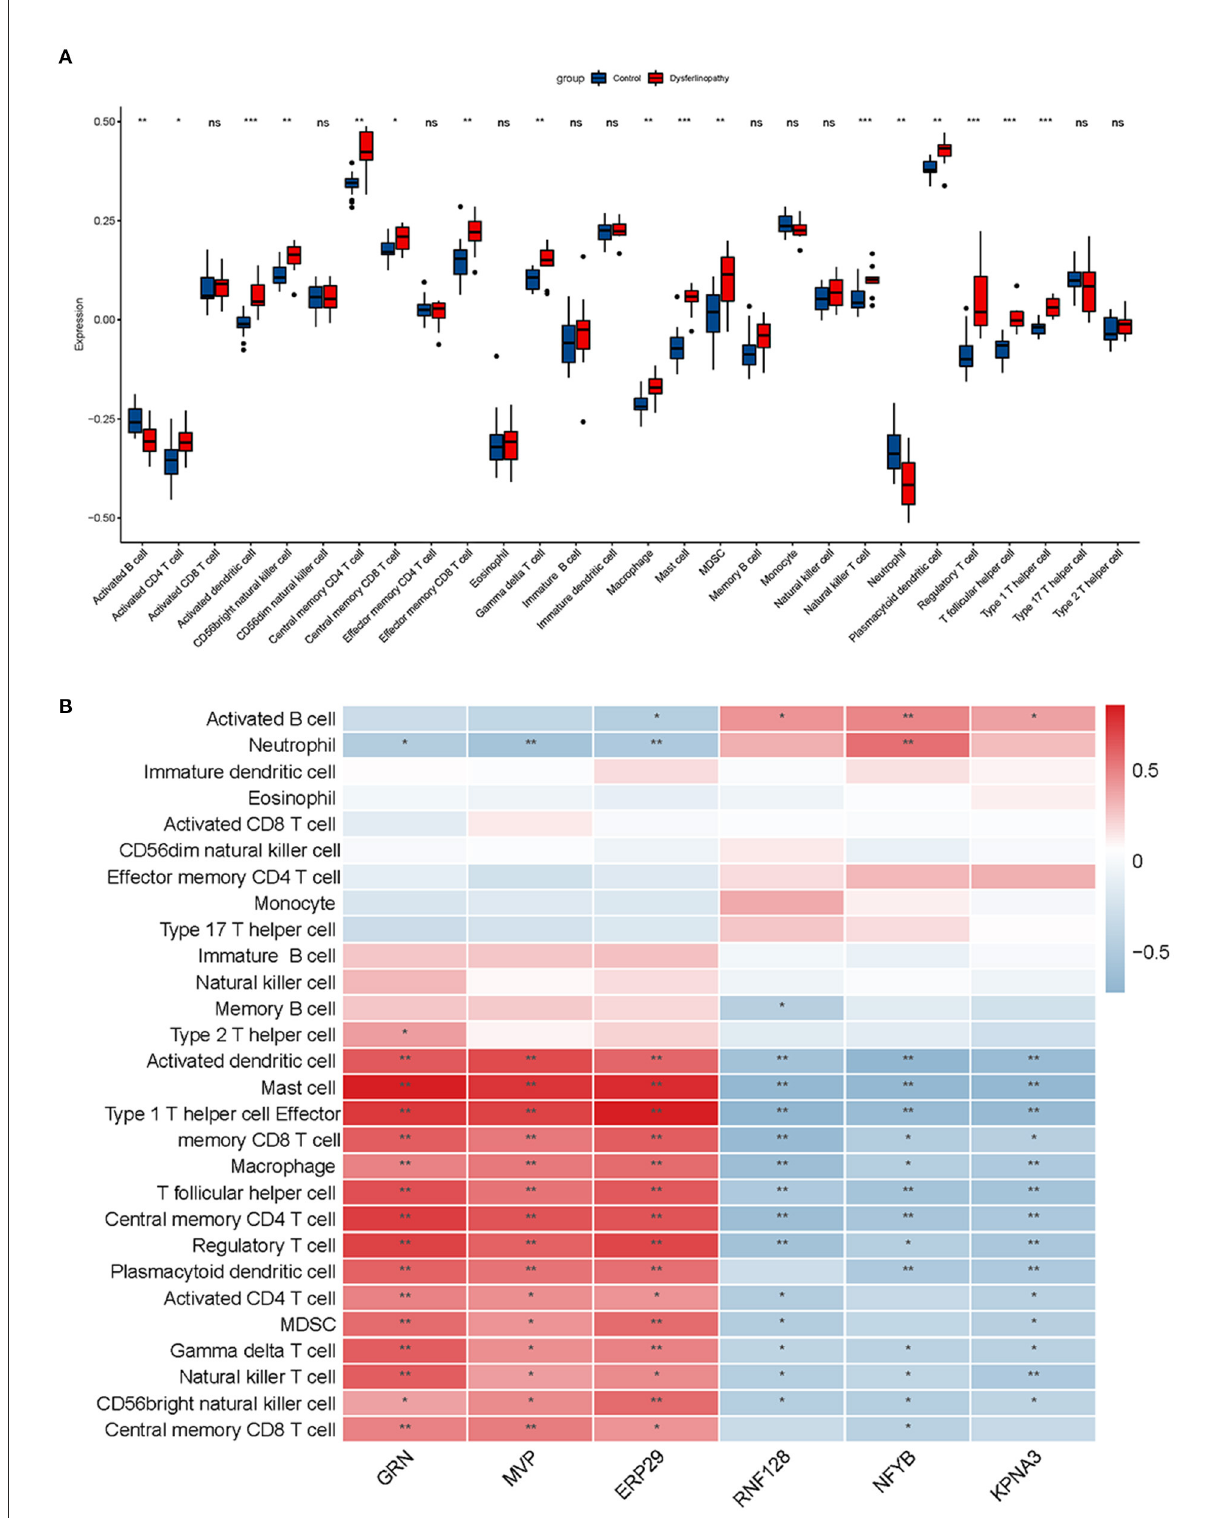
FIGURE8 Immune infiltration analysis associated with dysferlinopathy. (A) A comparison of 28 types of immune cells between dysferlinopathy and controls. (B) Infiltration levels of immune cells and six key genes in a heat map. Red indicates a strong positive correlation, whereas blue indicates a strong negative correlation. * p < 0.05; ** p <